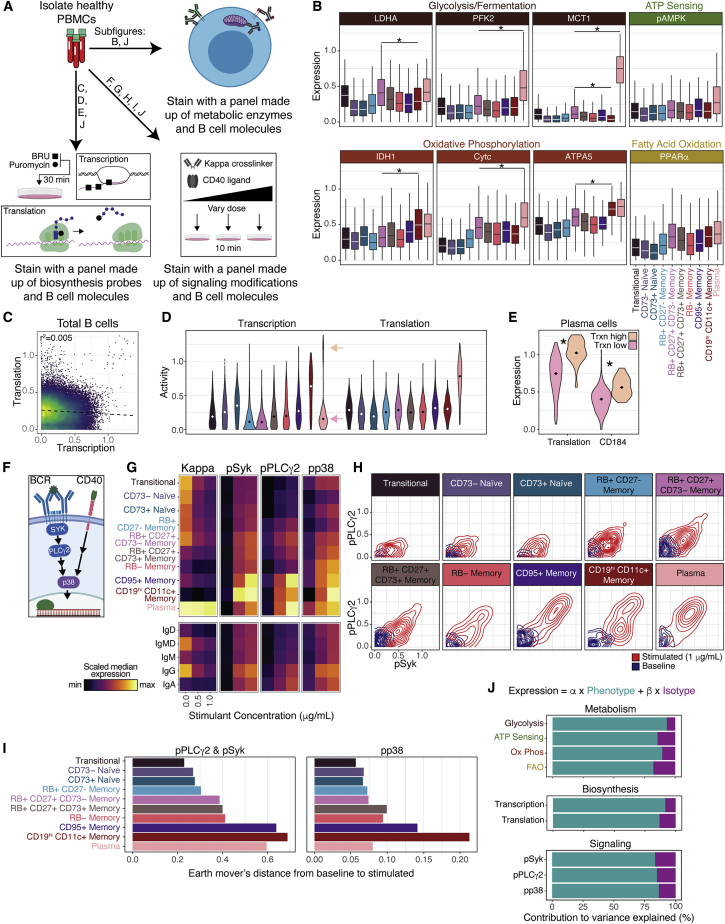
Interrogation of B cell subset function reveals differential metabolic, biosynthesis, and immune signaling activity(A) Experimental workflow (n = 9 donors).(B) Expression of metabolic enzymes. Stars indicate significance (p < 0.005). Boxes represent interquartile range (IQR) and whiskers represent IQR +/− 1.5*IQR(C) Biaxial of biosynthesis activity.(D) Violin plots of biosynthesis activity. Bimodality indicated by arrows.(E) Violin plots of significantly differentially expressed molecules (p < 0.005).(F) Signaling diagram.(G) Median expression of Igλ− B cells, grouped by phenotype or isotype.(H) Contour plots of signaling molecules.(I) Quantification of earth mover’s distance from baseline samples to stimulated samples (1 μg/mL) for pPLCγ2 and pSyk and pp38.(J) Relative contribution of phenotype and isotype to the variance explained by linear models created to predict single-cell expression of metabolic pathways, biosynthesis activity, or cell signaling.